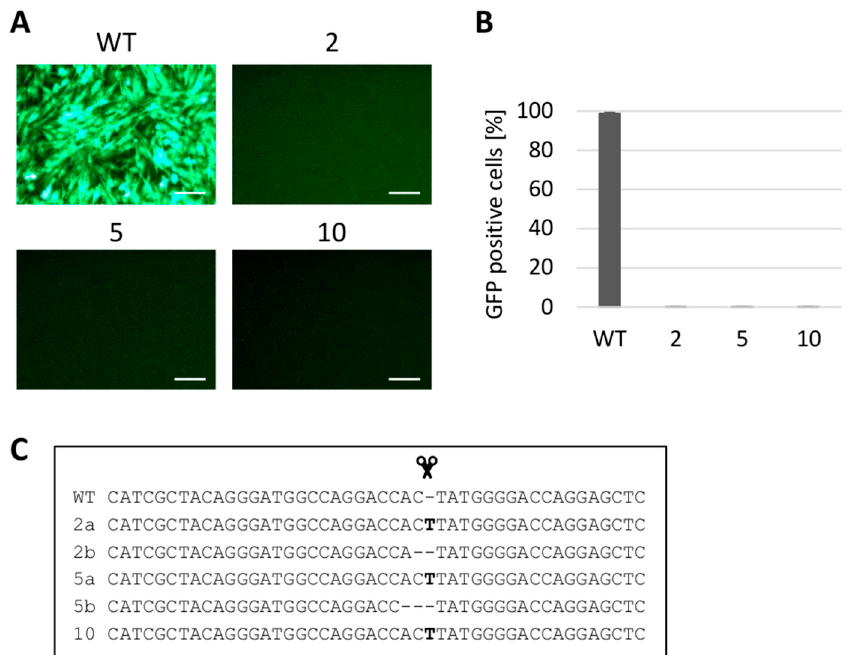
Figure 3. Analysis of ALV-C-resistant clones of DF-1 cells. The selected clones 2, 5, and 10 were challenged with the RCASBP(C)GFP reporter virus. The virus spread in the cell culture was assayed as the presence of GFP-positive cells by fluorescence microscopy ( A ) or FACS ( B ). The indel mutations present in both tvc alleles of these three clones are shown ( C ) with the cleavage point represented by the scissors. Insertions of T nucleotides are shown as bold letters. The FACS experiment was done in two parallels in two independent experiments and the results are shown as the mean + standard errors. Scale bar = 100 μ m.